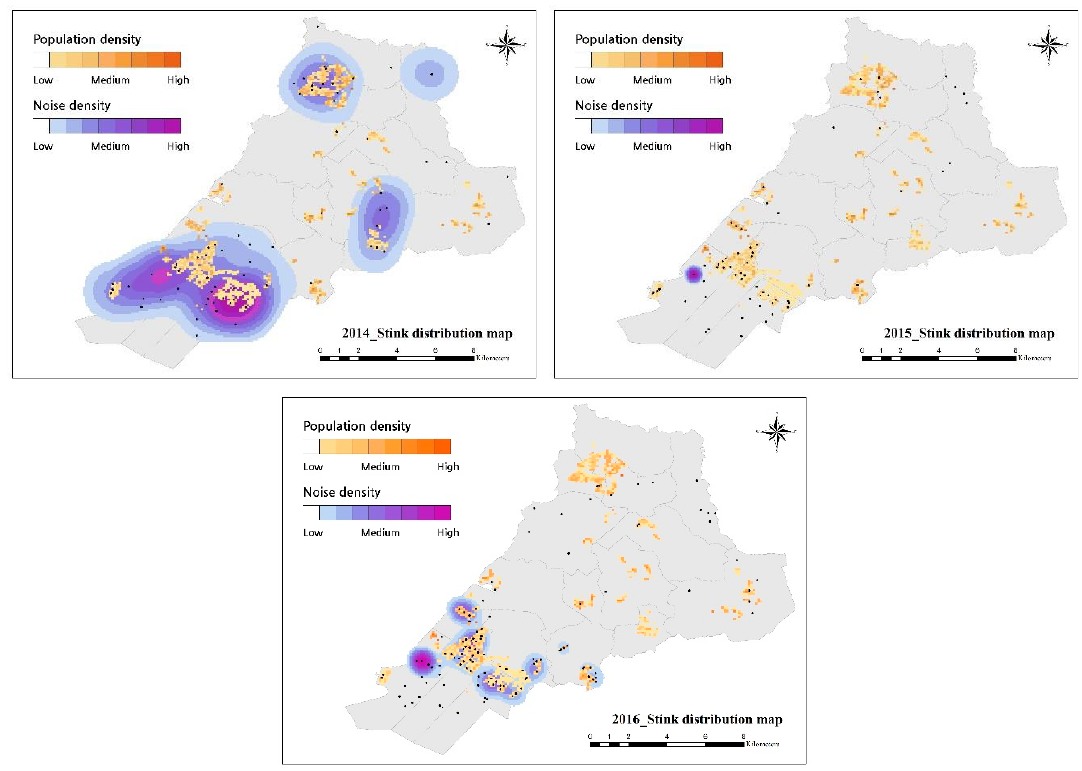
Figure 9. Annually the stink distribution F igure 9. Annually the stink distribution map.